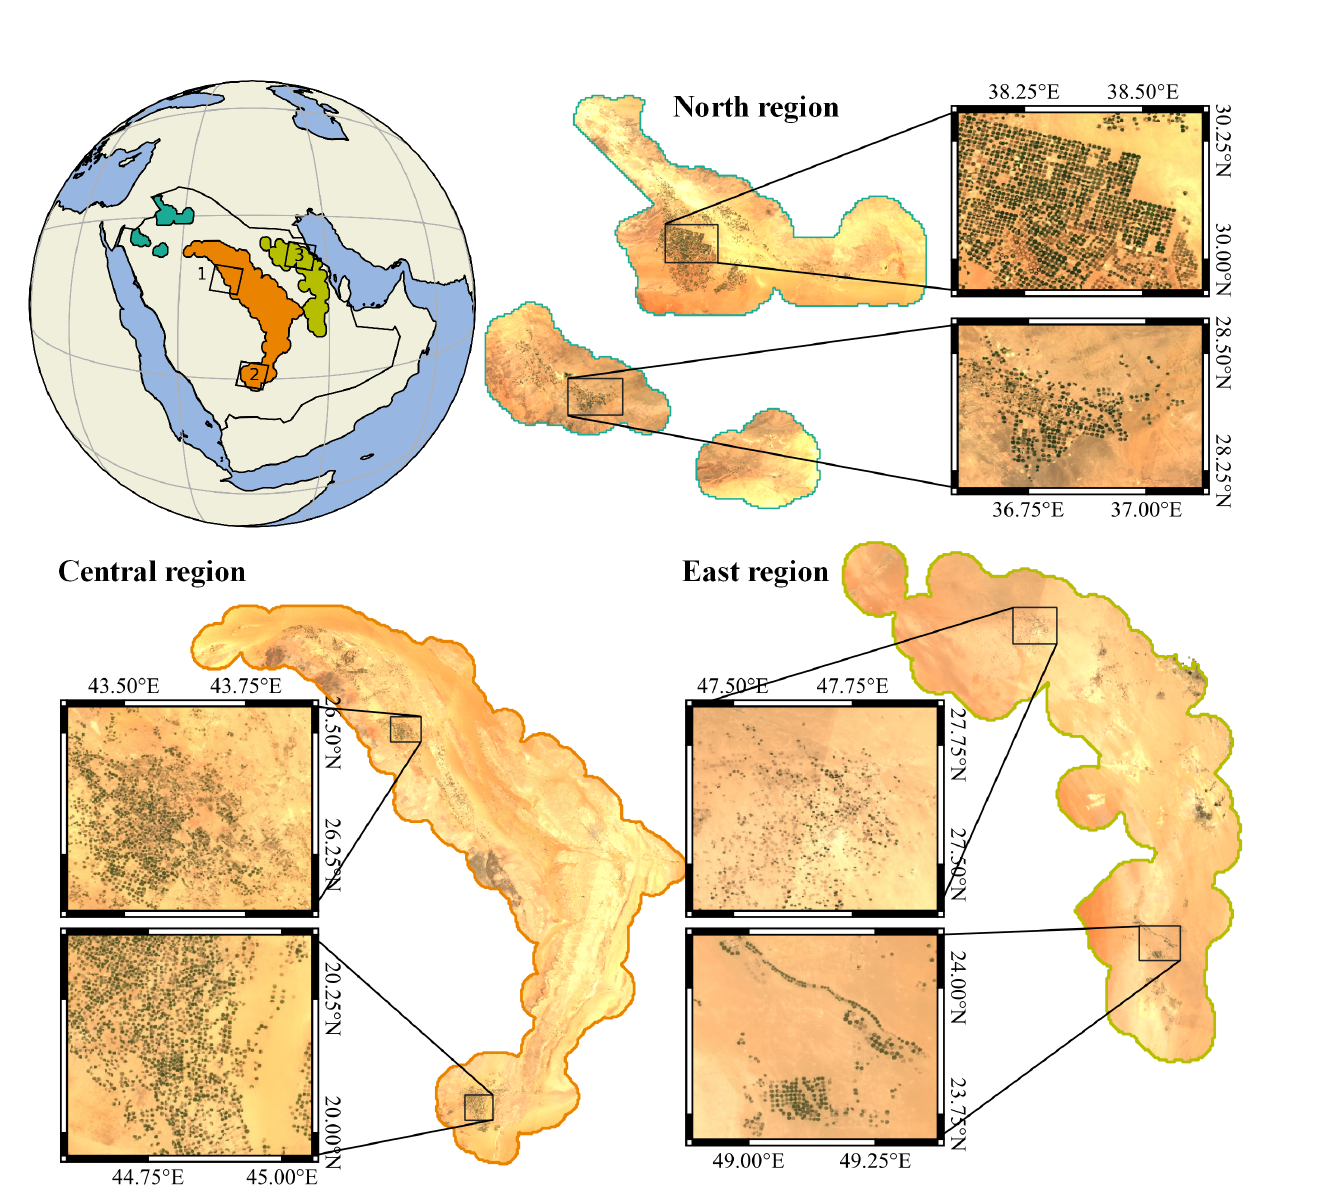
Figure 1. The study site showing the north, central, and east regions. The region boundaries were obtained by resampling a mask of maximum annual NDVI values higher than 0.25 to a resolution of 0.1 ◦ , followed by smoothing with a circular kernel. The black rectangles on the globe with digits 1, 2, and 3 indicate the three selected Landsat tiles (path/row) 168/42, 166/46, and 165/41, respectively, used to create a ground-truth dataset to evaluate the framework’s performance. The colors of the regional outlines correspond to the colors on the global